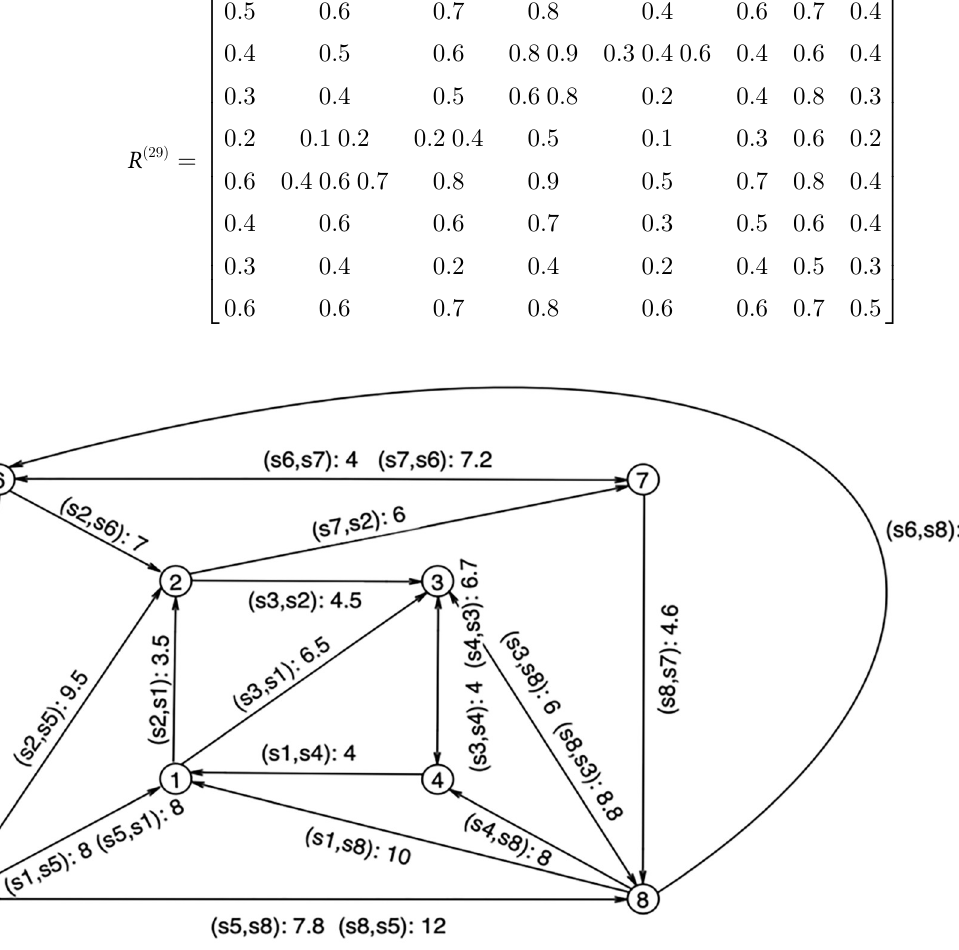
Fig 3. Risk contagion network of the automotive supply